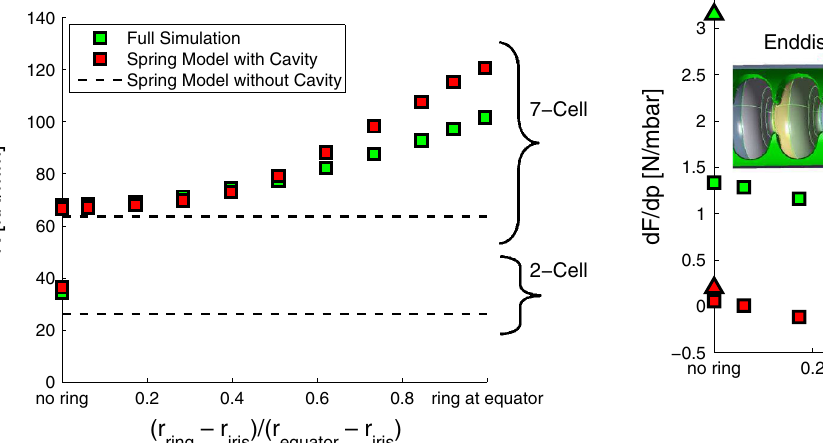
FIG. 11. dF=dp of the cavities, showing both the nominal result and the result if no pressure is applied to the end walls. In the latter case, the magnitude of dF=dp decreases nearly to